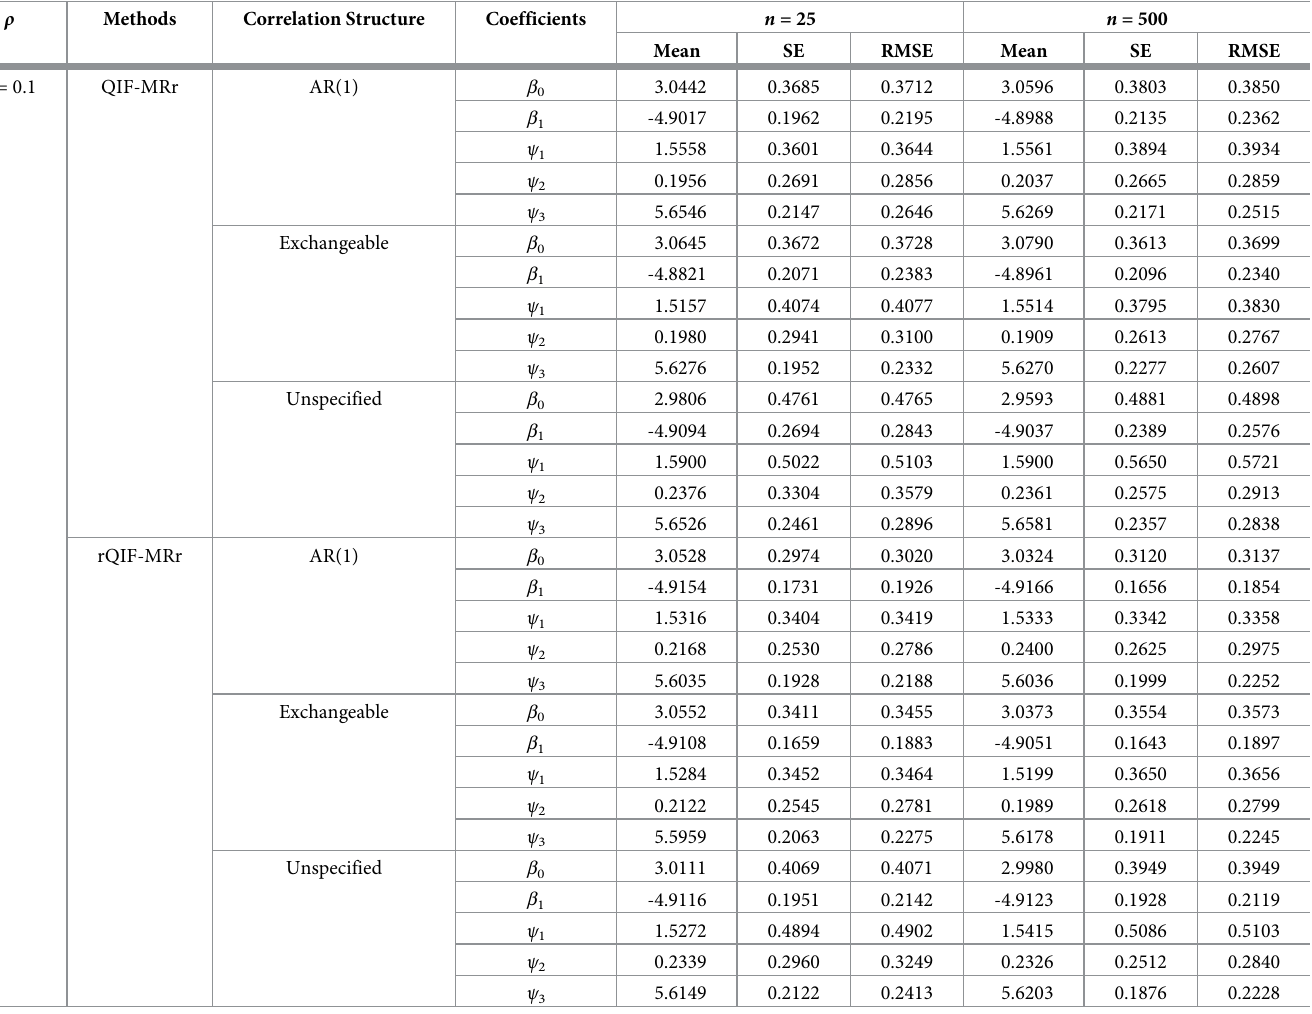
Table 2. Parameter estimation of the misspecification working correlation structures for the QIF-MRr and rQIF-MRr at low correlation value, ρ = 0.1. ρ Methods Correlation